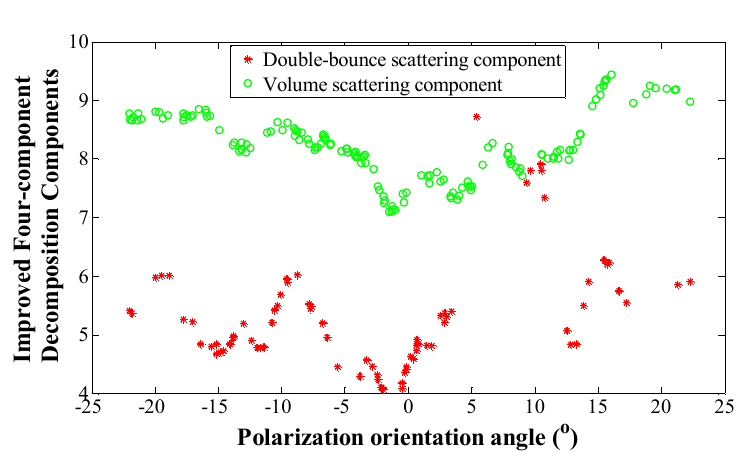
Figure 3. Scatter diagrams for the double-bounce scattering (DBS) component and the volume scattering (VS) component of the oriented building samples generated by the two decomposition methods.